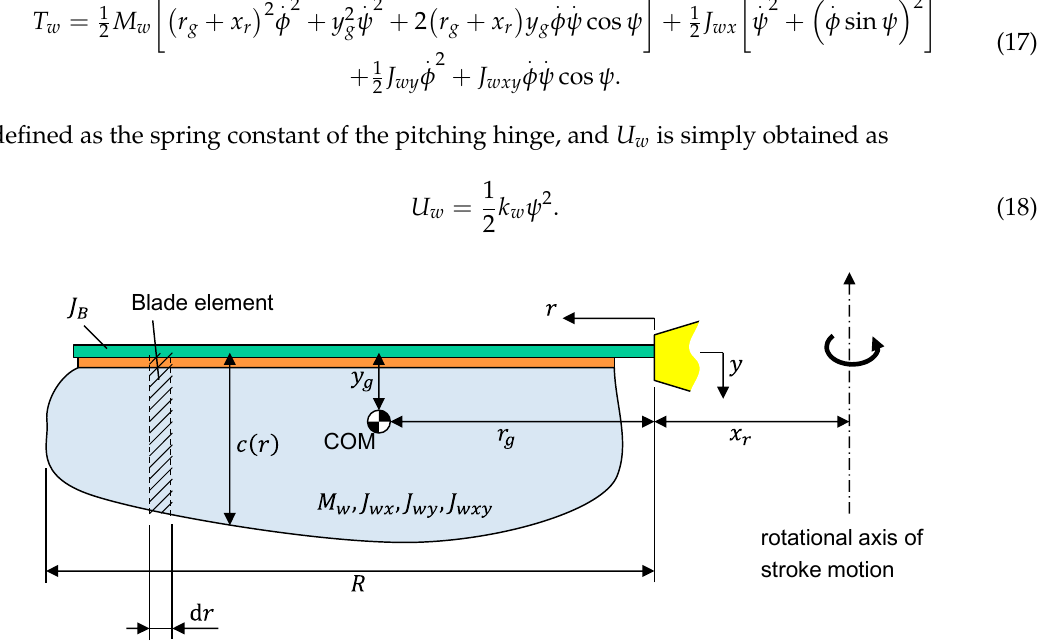
Figure 3. Coordinates and dimensional parameters of wing.